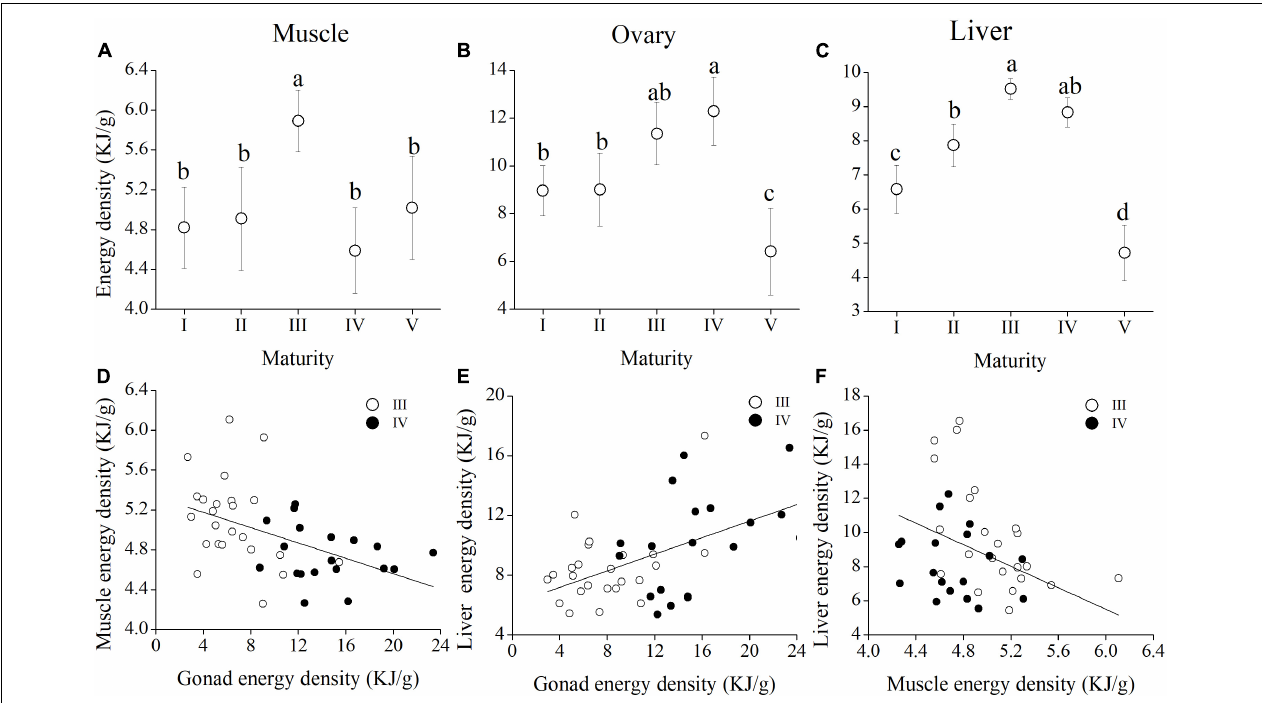
FIGURE 7 | Changes in energy density across Megalobrama terminalis female maturity stages in the muscle (A) , ovary (B) , and liver (C) . Scatter plots indicating the relationships of energy density in specific tissues [muscle (D) , ovary (E) , and liver (F) of M. terminalis female in maturity stages III and IV. Different superscript letters indicate significant differences of energy density in different maturity stages, p <